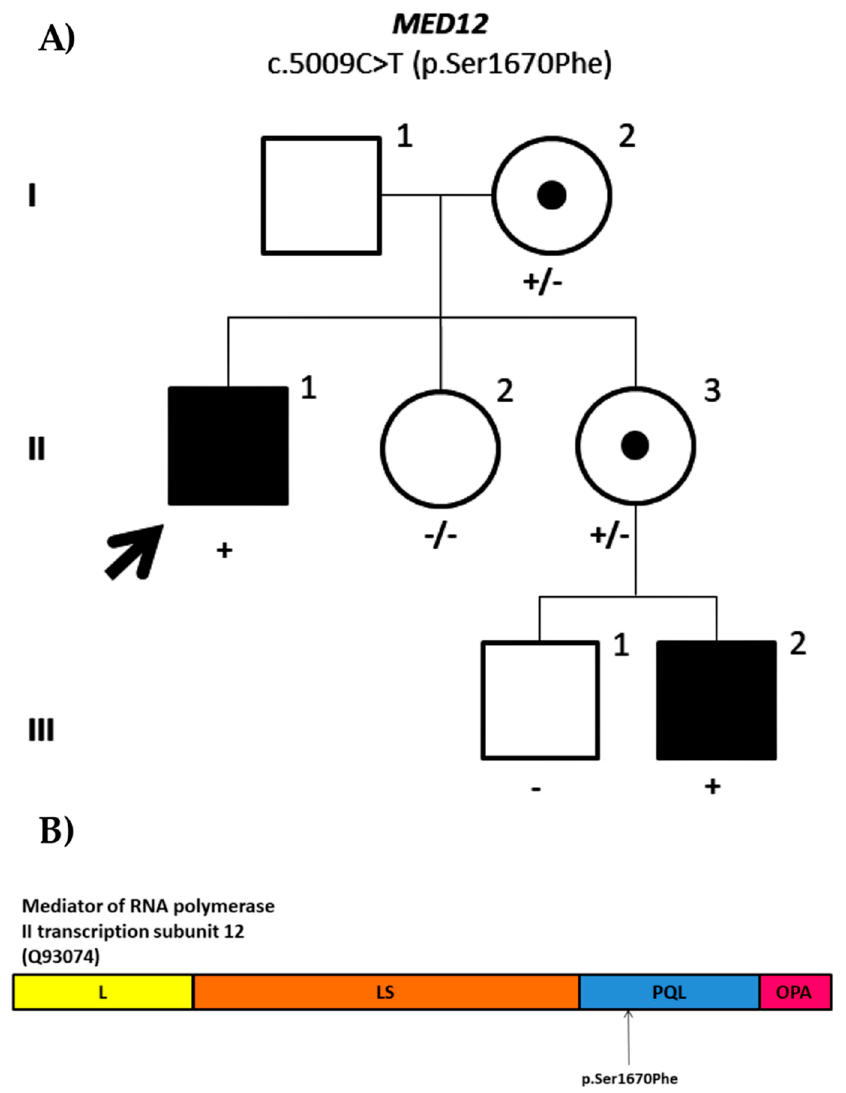
Figure 7. ( A ) Family pedigree of the ID1405 proband. Segregation analysis of the missense variant in MED12 (NM_05120.2: c.5009C>T; p.Ser1670Phe). ( B ) Mediator of RNA polymerase II transcription subunit 12. The subunits of the protein encoded by MED12 include leucine-rich domain (L) in yellow, leucine serine-rich domain (LS) in orange, proline glutamine and leucine-rich domain (PQL) in blue, and glutamine-rich domain (OPA) in pink. The variant identified in ID1405 is located on the PQL domain as shown in the